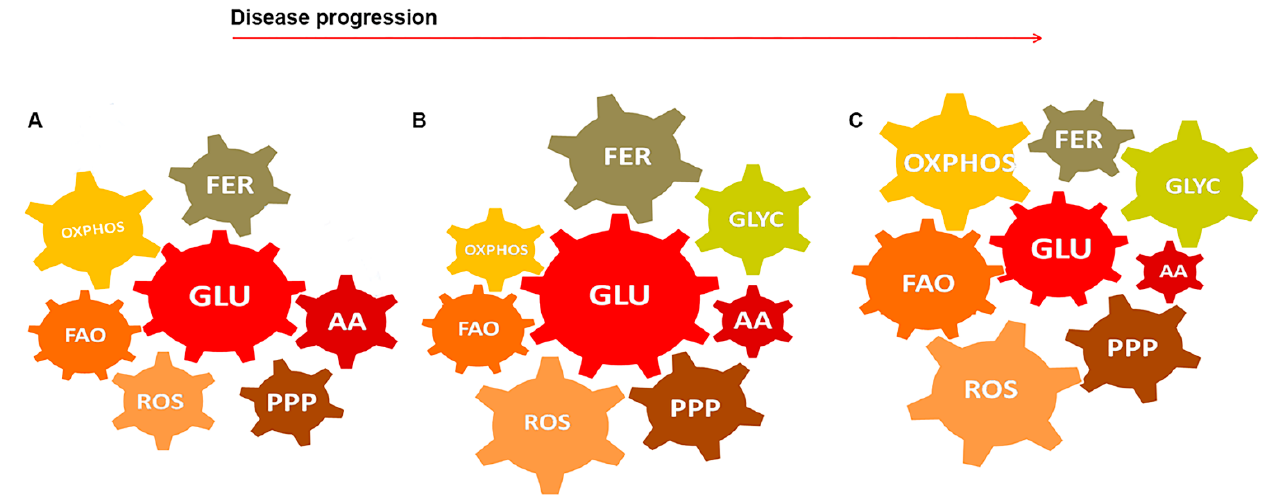
Figure 2. Metabolic modules in the GBM-glial cell network during the disease progression. ( A ) Metabolic modules may be considered as gears regulating the engine performance, that is the bioenergetic machinery in biological tissues. Based on the literature review, we hypothesized the relationships between the metabolic modules in the GBM-glial cells network. In physiological conditions, glucose oxidation-derived products allow both the OXPHOS, FER, and PPP. The ROS production is counterbalanced by the AA pool, which is partially used for synthesizing anti-oxidant agents. Fatty acid oxidation also precedes ATP production and substrates for biosynthesis. ( B ) With the presence of GBM, metabolic and mitochondrial rewiring occurs. Both cancer and non-cancer cells are supposed to rely on glycolytic metabolism and PPP for ATP and biosynthesis need respectively. ROS production exceeds and impairs the mitochondrial OXPHOS. Astrocytes maintain the FER to fulfill the neurons’ metabolic needs. Glycogen and non-essential AA are recruited as an alternative source of glucose. ( C ) In the condition of glucose starvation, glycogen deposits and AA keep on fuel the energetic and biosynthetic metabolism [189]. FAO acquires a major role to sustain the OXPHOS, but the overproduction of ROS may trigger new adaptations and maladaptive plasticity. Glucose oxidation (glycolysis, GLU); anaerobic fermentation (FER), amino acids (AA), oxidative phosphorylation (OXPHOS); reactive oxygen species (ROS); pentose phosphate pathway (PPP); fatty acid oxidation (FAO); glycogenolysis (GLYC).